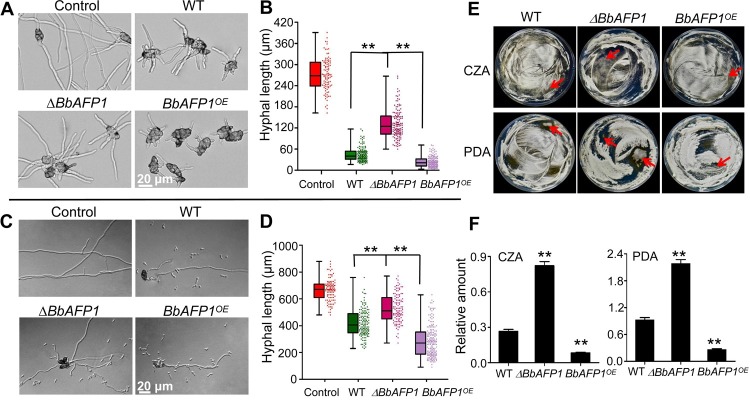
Consequence of BbAFP1 targeted gene deletion and overexpression on A. brassicae antifungal activity.(A, B) Representative images and quantification of fungal growth inhibition using protein fractions released from conidia (ultrasonic treatment) of B. bassiana wild type, ΔBbAF1 and BbAFP1OE as evaluated against A. brassicae growth in PDB. (C, D) B. bassiana-A. brassicae co-culture experiments. Representative images and quantification of the effects of B. bassiana wild type, ΔBbAFP1 and BbAFP1OE on conidial germination of A. brassicae on CZA using a B. bassiana test strain:A. brassicae initial conidial ratio = 30:1. Growth inhibition was evaluated after 14 h of co-cultivation. (E) B. bassiana test strain-A. brassicae co-cultivation using an initial conidial ratio = 30:1 and plated on CZA or PDA, 4 d post-coinoculation. Red arrows indicate brown A. brassicae colonies, with B. bassiana growth forming white mycelia. (F) Quantification of A. brassicae growth in co-cultivation as measured by real-time PCR using total genomic DNA extracted from the fungal mixtures on plates. The reference gene used was actin (the designed primer was non-specific capable of giving product for both B. bassiana and A. brassicae), and the AbreAtr1 gene of A. brassicae was used as target gene, with primers designed to amplify the sequence from A. brassicae but not B. bassiana. All experiments were performed in triplicate with at least three independent biological samples. Error bars = SD, ** indicates P < 0.01, t-test.